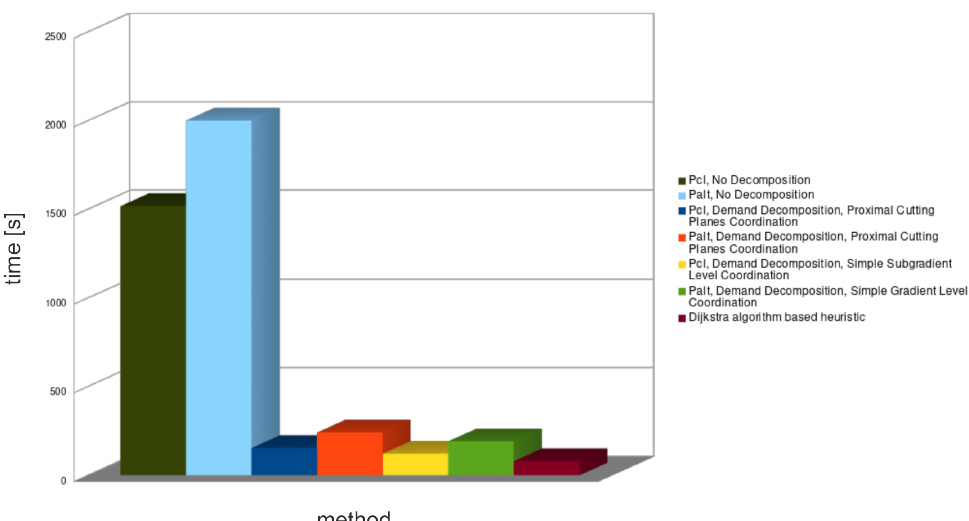
Figure 10. Average spent time for all decomposition methods—large